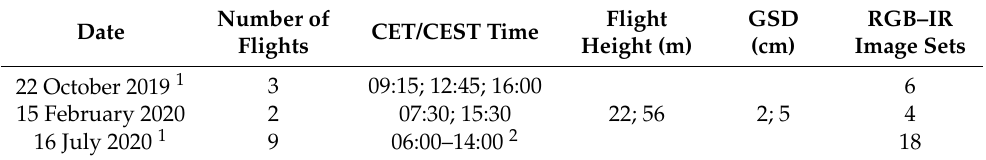
Table 2. Data surveys